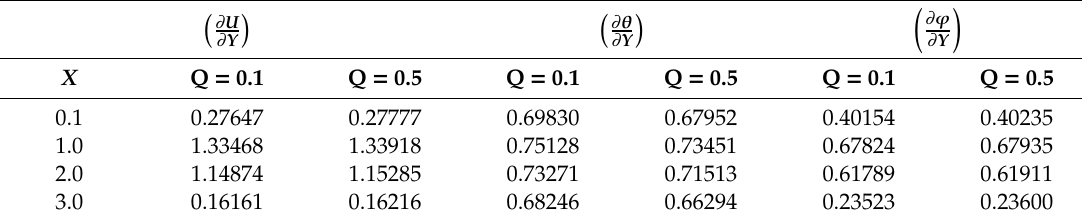
Table 3. Physical e ff ects on quantities ∂ U ∂ are constant.